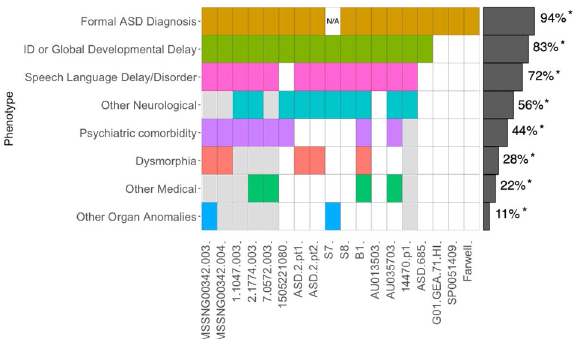
Fig. 2 Phenotypic heterogeneity in individuals (X-axis) carrying the SHANK3 p.Ala1227Glyfs*69 variant reported in the MSSNG 6 , SSC 32,33 , and in published papers 4,36,38 – 42,71 . Those individuals in the same family are grouped within the black boxes. Gray spaces indicate the absence of the phenotype. White spaces indicate that the phenotype might have not been accessed in the proband. Phenotypic categories are described in Table 3. Individual S7 was not formally reported as being formally tested for ASD. *Caution is needed in the interpretation of these frequencies since some phenotypes were not assessed for some